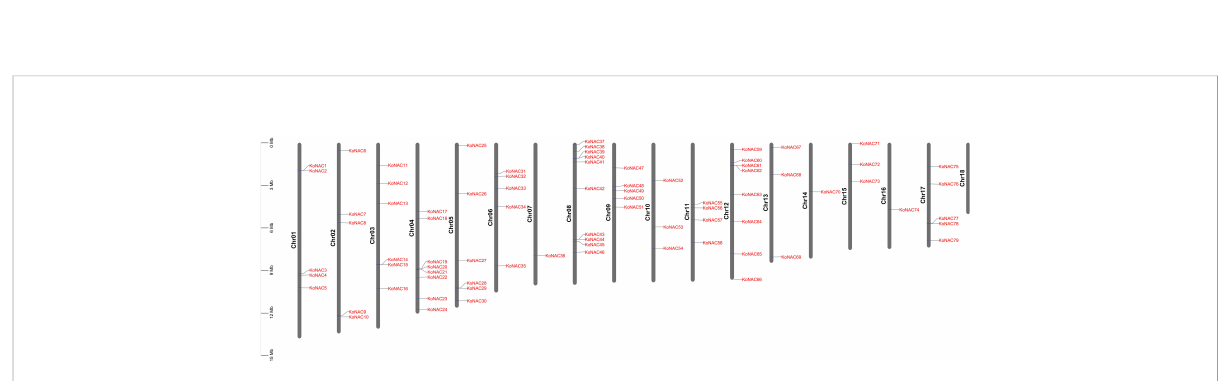
FIGURE 3 Distribution of 79 KoNAC genes on 18 chromosomes. Vertical bars represent the chromosomes of Kandelia obovata . The chromosome number is on the left of each chromosome. The scale on the left represents the length of the chromosome.